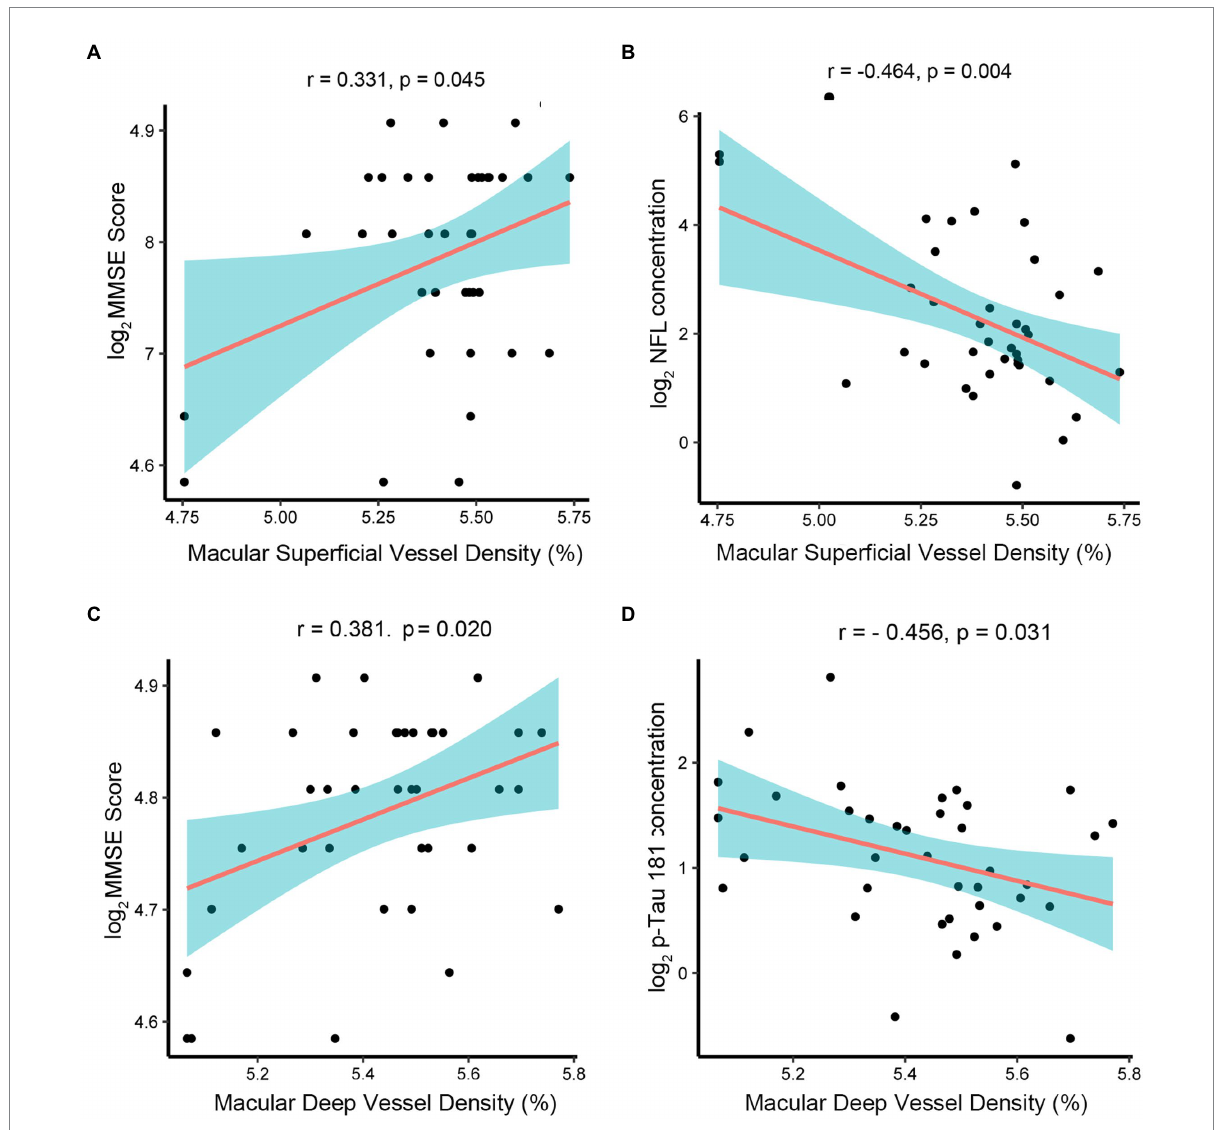
FIGURE 4 Associations between retinal thickness, retinal vessel density, and AD-related proteins in AMD group. The AD-related biomarkers concentrations and MMSE scores were log-transformed. p < 0.05 was considered statistically significant. The blue area represented the 95% confidence interval. (A,B) The macular whole enface superficial vessel density values had a positive correlation with MMSE scores ( r = 0.331, p = 0.045) but a negative correlation with the concentration of NfL ( r = − 0.464, p = 0.004). (C,D) The macular whole enface deep vessel density values were positively correlated with MMSE scores ( r = 0.381, p = 0.020) and negatively correlated with the concentration of p-tau181 ( r = − 0.456, p =